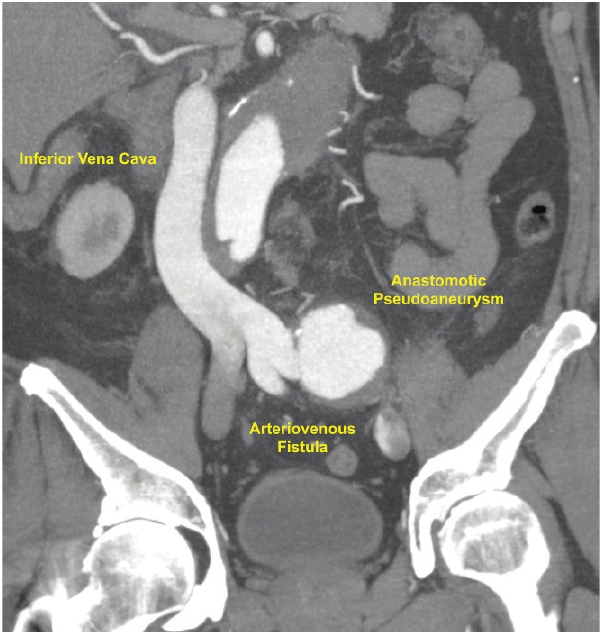
Figure 1 - Contrast-enhanced computed tomography angiogra- phy (CTA), showing the anastomotic pseudoaneurysm and the ilio-iliac arteriovenous fistula. The inferior vena cava is fully contrasted, indicating an arteriovenous